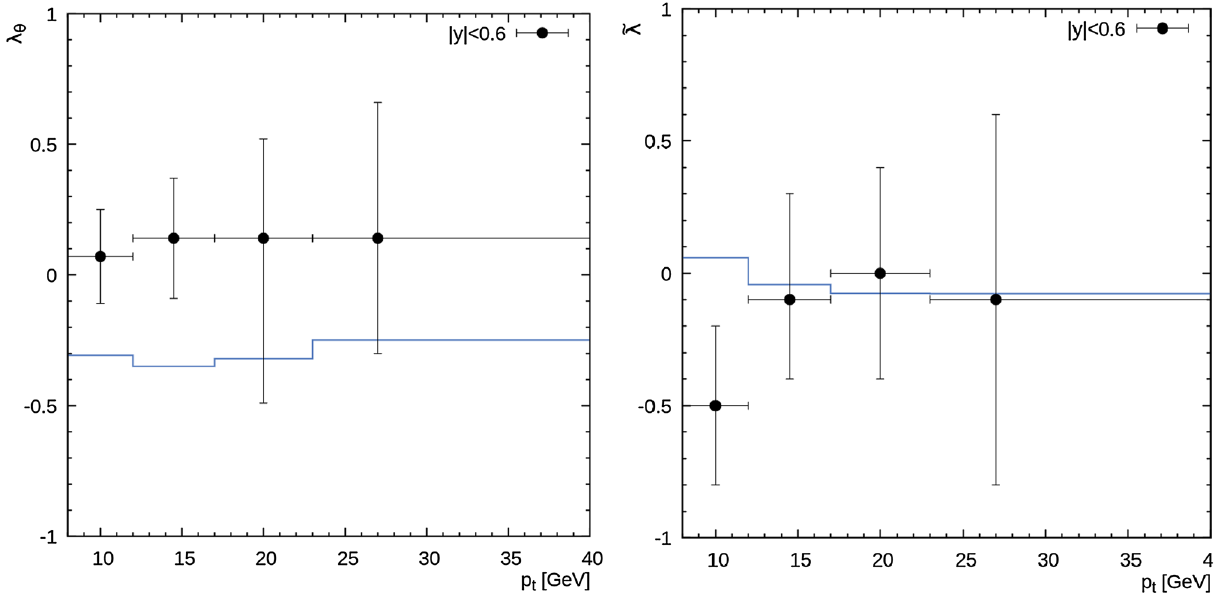
Fig. 10 The polarization parameters λ θ and ˜ λ of ϒ( 3 S ) mesons calculated in the helicity frame as function of its transverse momentum at √ s = 1 . 96 TeV. Notation of all histograms is the same as in Fig. 7. The experimental data are from CDF